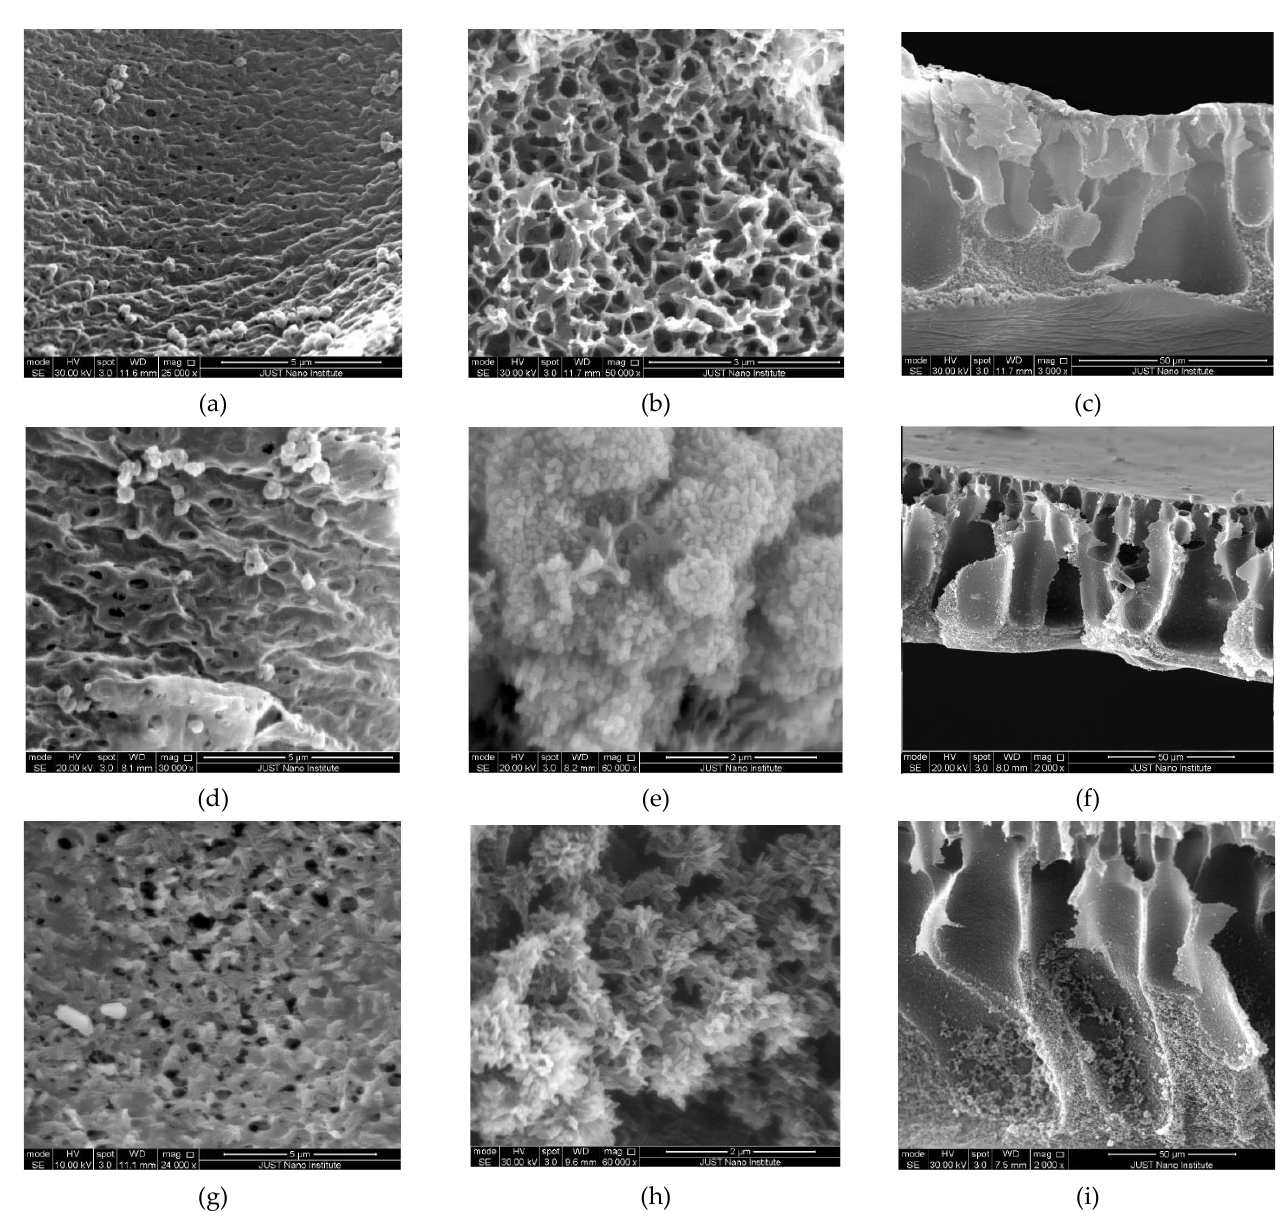
Figure 3. SEM morphologies of the pristine CA membrane ( a , b , c ), the CA-ZnO-NP membrane ( d , e , f ), and the CA-ZnO-NW membrane ( g , h , i ). Images on the left, middle, and right correspond to the top surface, bottom surface, and cross-sectional images of the membranes, respectively.